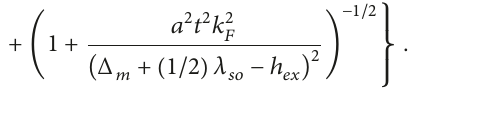
K − are opposite indicating that both of valleys are related to time reversal symmetry. On the other hand, from (26) and (27) and the total spin Hall conductivity vanishes